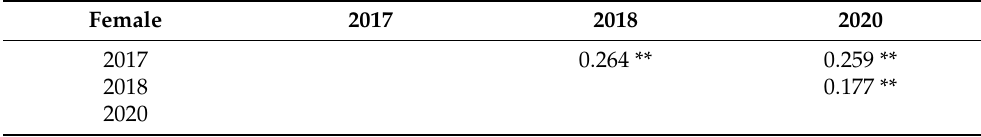
Table 4. The Spearman’s rank correlation coefficient of female strobilus productions between years based on pooling of families.